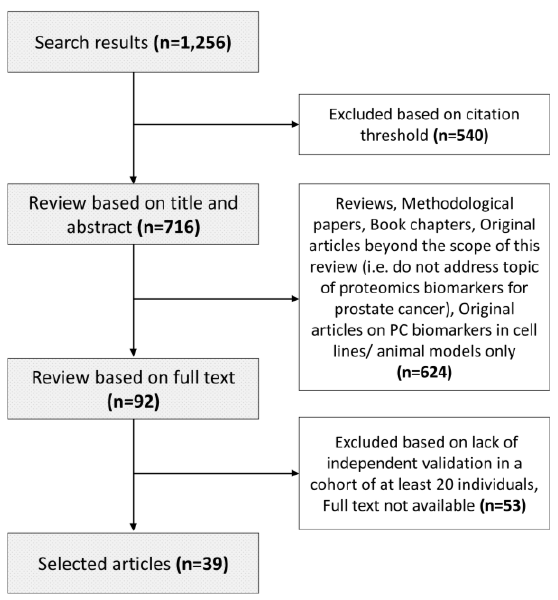
Figure 3. Graphical representation of the conducted literature search and review strategy.